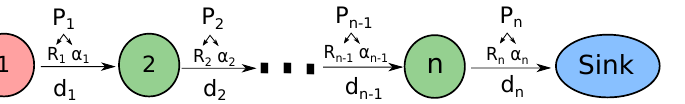
Figure 2. Multi-hop line network model. The PDR of link i , between nodes i and i + 1, is P i with parameters R i , α i , and its length is d i